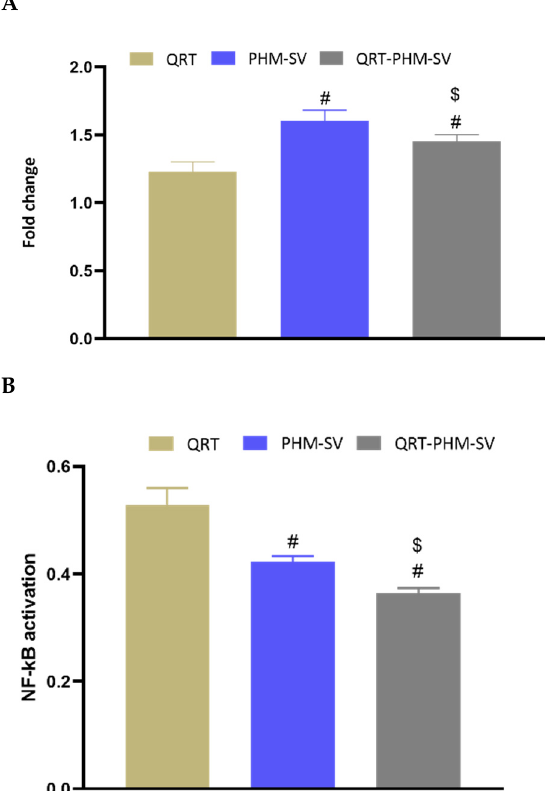
Figure 12. Effect of the QRT-PHM-SV formula on the mRNA expression of TNF- α ( A ) and the activation of NF- κ B ( B ) in MCF-7 cells. Data presented in bar charts are ± SD (n = 3). # or $, statistically different from QRT or plain formula (PHM-SV), respectively, at p < 0.05.